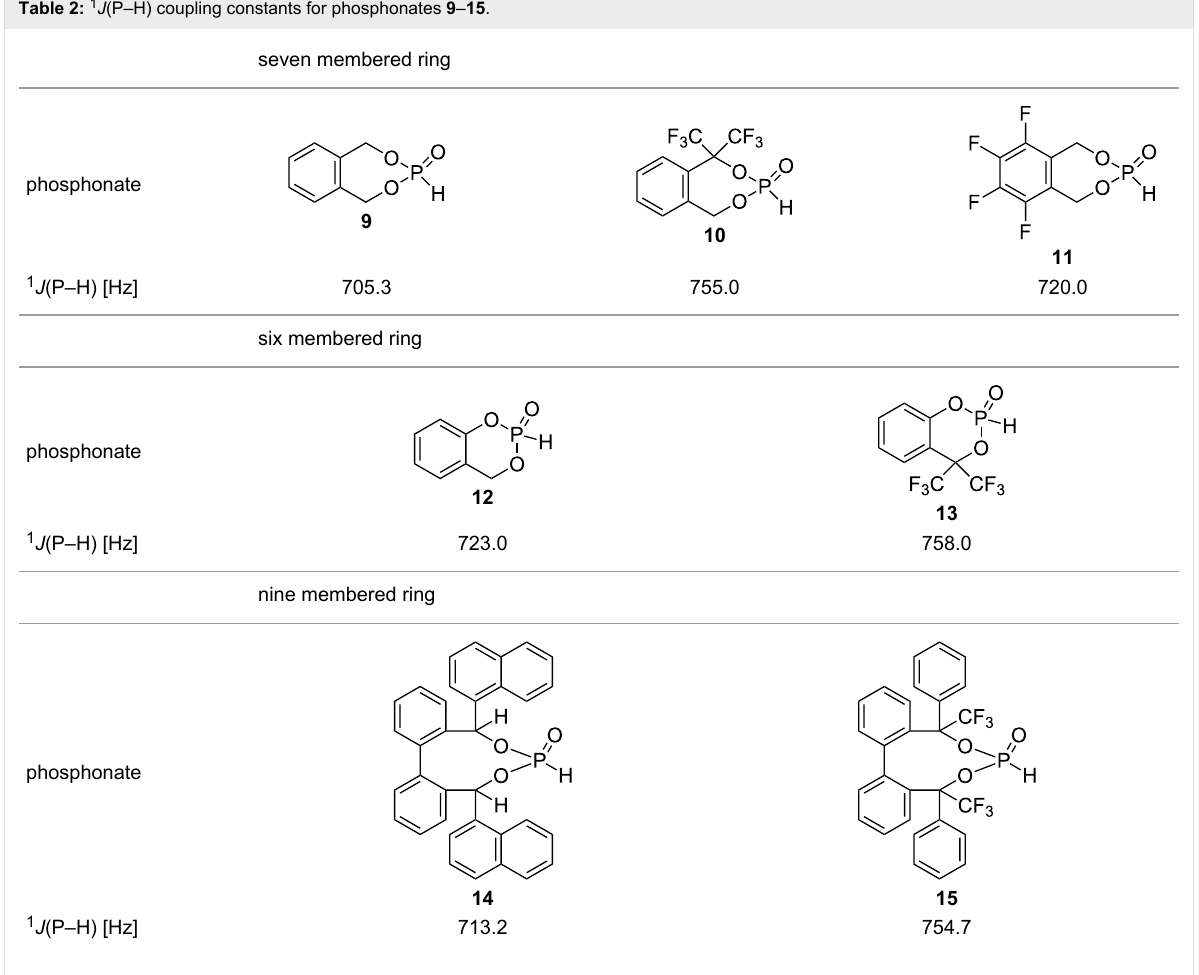
Table 2: 1 J (P–H) coupling constants for phosphonates 9 – 15